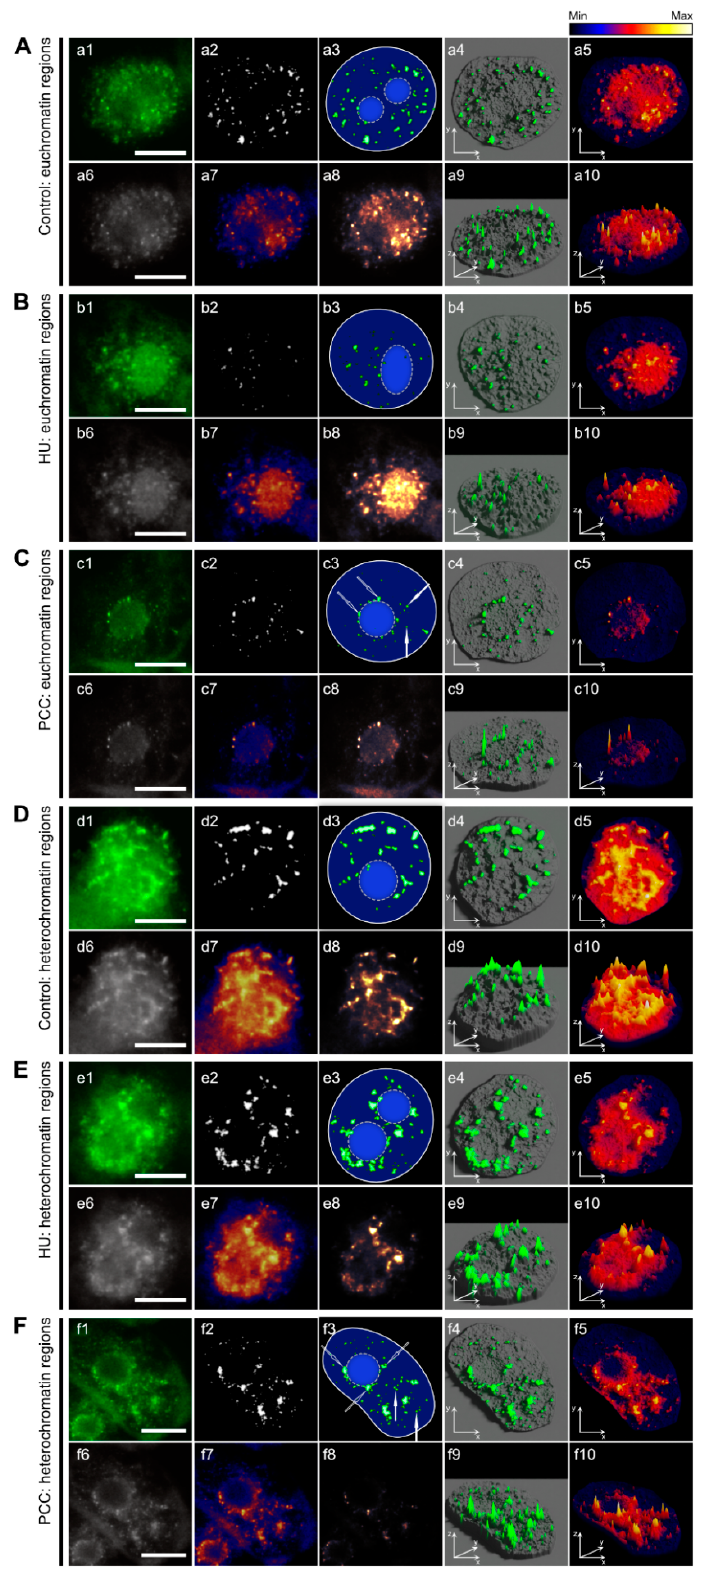
Figure 4. The differences between the pRb activity in euchromatic ( A – C ) and heterochromatic ( D – F ) regions of the nuclei were compared between the control, HU, and PCC series. Images with number 1 are original images acquired via fluorescence microscope (AlexaFluor 488). Images with number 2 are binary images, thresholded to show only the most active pRb foci. Images with number